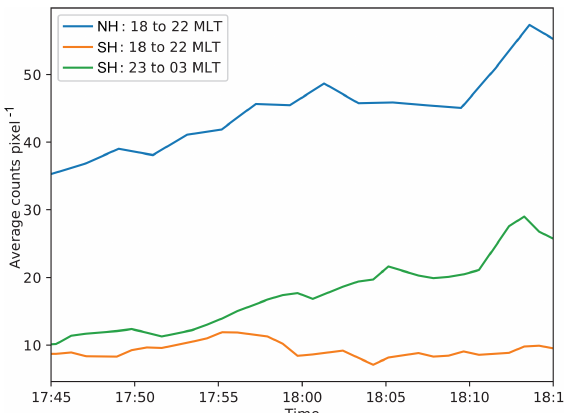
Figure 15. Average counts per pixel between 55 and 75 ◦ mag- netic latitude in selected MLT sectors from 17:45 to 18:15UT on 17 August 2001. Blue line: Northern Hemisphere 18–22MLT; or- ange line: Southern Hemisphere 18–22MLT; and green line: South- ern Hemisphere